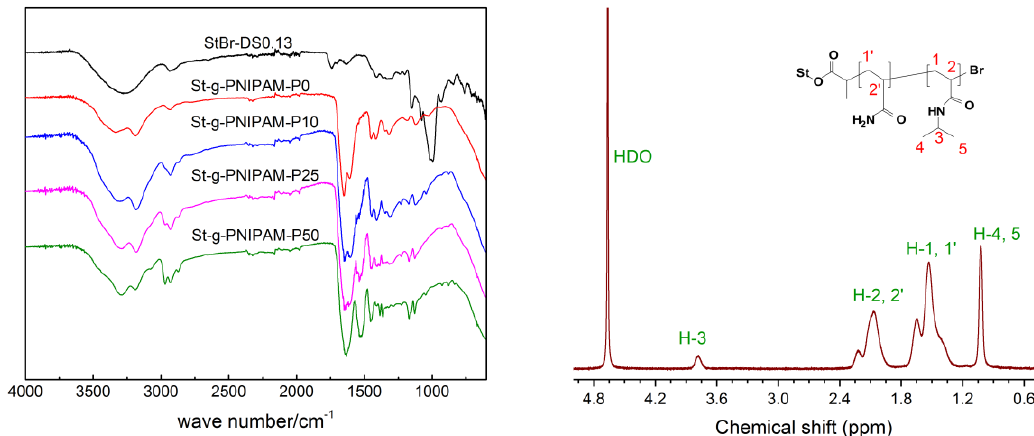
Figure 1. FTIR spectra of StBr and Starch-g-poly(acrylamide-co- N -isopropylacrylamide) (St-g-(PAM-co-PNIPAM)) with different N-isopropylacrylamide (NIPAM) mole ratio ( Left ) and 1 H-NMR spectra of St-g-(PAM-co-PNIPAM) in D 2 O ( Right ).